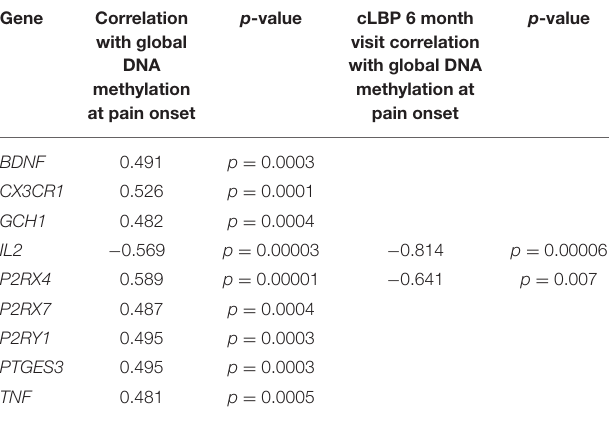
H4 acetylation at